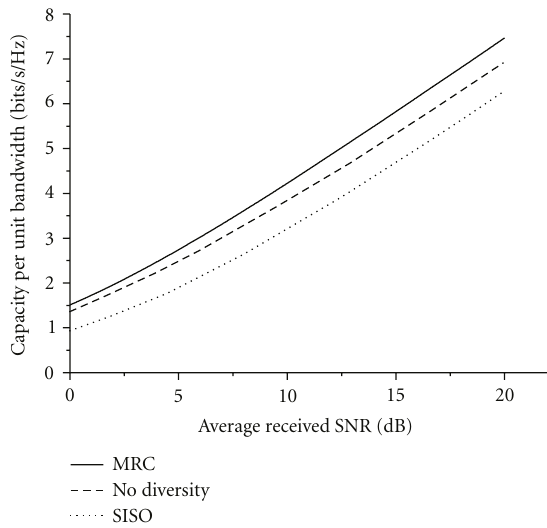
Figure 2: Capacity per unit bandwidth of a dual branch Nakagami- m fading channel with EGC diversity as a function of the average received